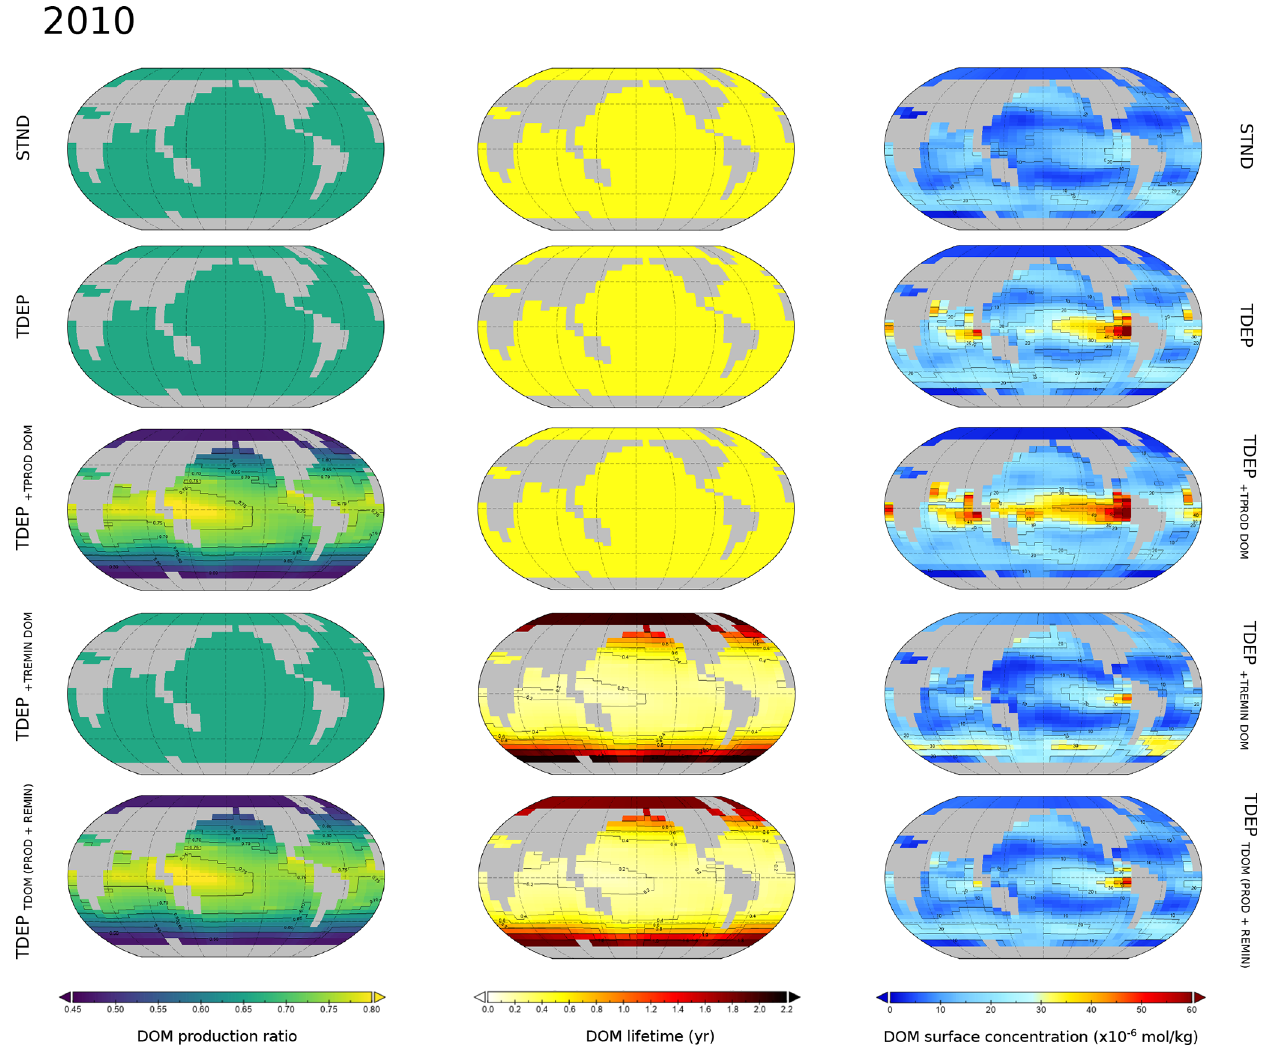
Figure A1. Surface ocean DOM production ratio, DOM lifetime, and DOM concentration for the modelled present day (year 2010). Labelled simulations include those discussed in the main text (STND, TDEP, and TDEP + TDOM ); TDEP + TDOM is labelled here as TDEP TDOM ( PROD + REMIN ) for clarity. Also mapped are DOM production and remineralisation temperature dependence separately applied as TDEP + TPRODDOM TDEP + TREMINDOM